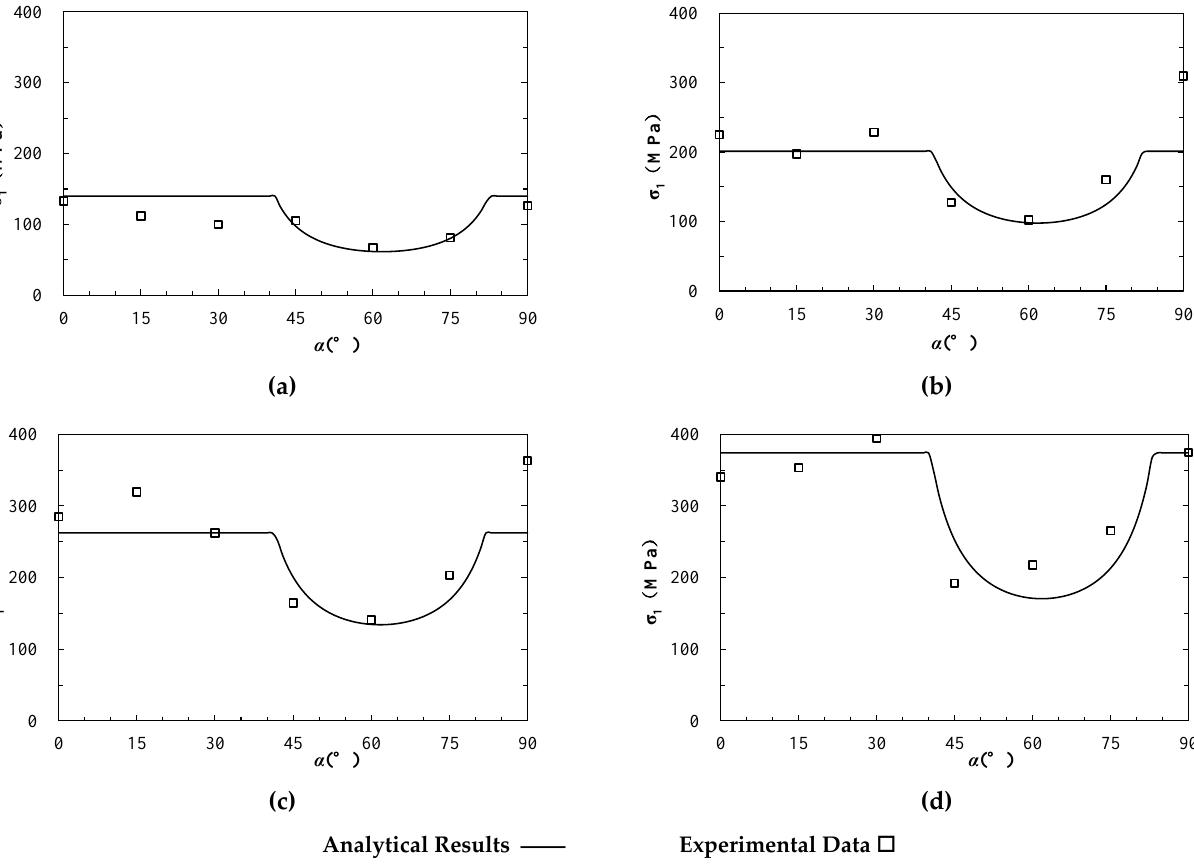
Figure 5. The analytical and experimental strength of anisotropic sandstone (modified based on [58]). ( a – d ) represent the results under uniaxial compression and triaxial compression at different confining pressure ( 𝜎 3 ) of 10.5, 21 and 31.5 MPa, respectively.